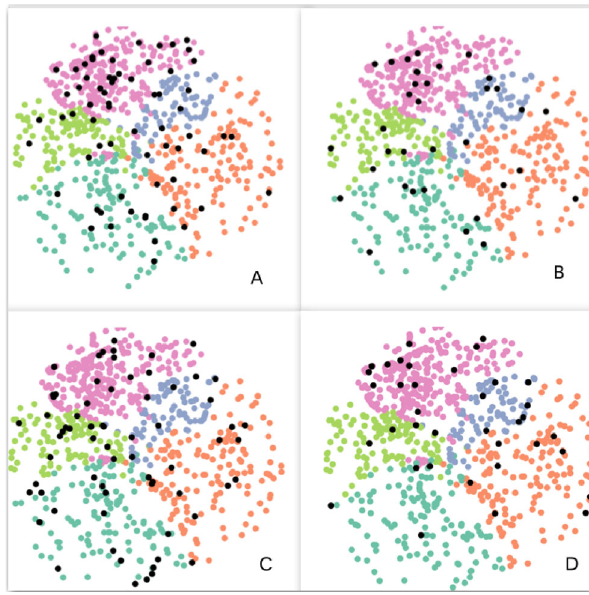
Fig. 8 Hacker attack case: topic distribution changes inside the event, and distribution shifts in alphabetical